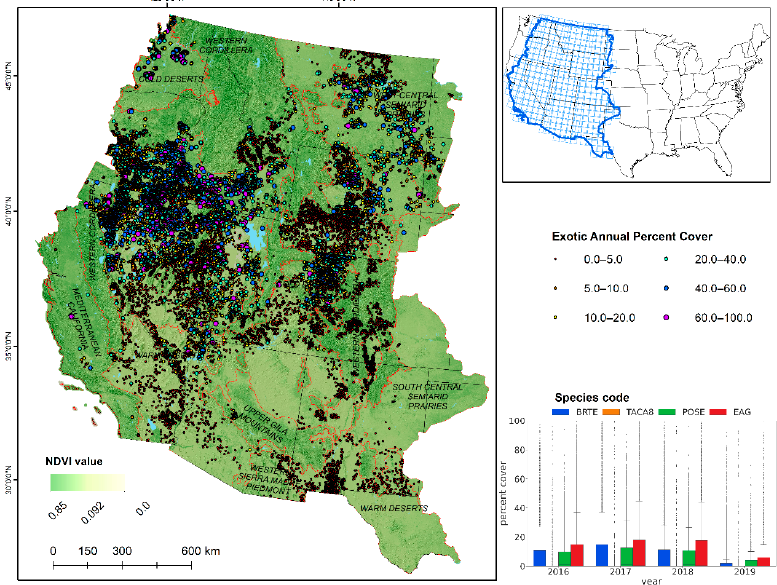
Figure 1. Field observations of the exotic annual grass abundance overlain on a hillshade model and maximum Normalized Difference Vegetation Index for 2021. Black lines represent state boundaries. Red lines are Omernik Level II ecoregions boundaries [25], and blue polygons represent permanent terrestrial water bodies. (Inset): 376 individual Harmonized Landsat/Sentinel-2 mapping units overlain with Conterminous United States (upper) and box and whisker plots (lower) showing distribution of selected grass species for training data over the years. The boxes represent interquartile range with horizontal line inside them indicating median values. The whiskers extend to a range that is within the median values ±1.5 times the interquartile range. EAG represents a combination of 16 exotic annuals, BRTE is cheatgrass, TACA8 is medusahead, and POSE is Sandberg bluegrass.